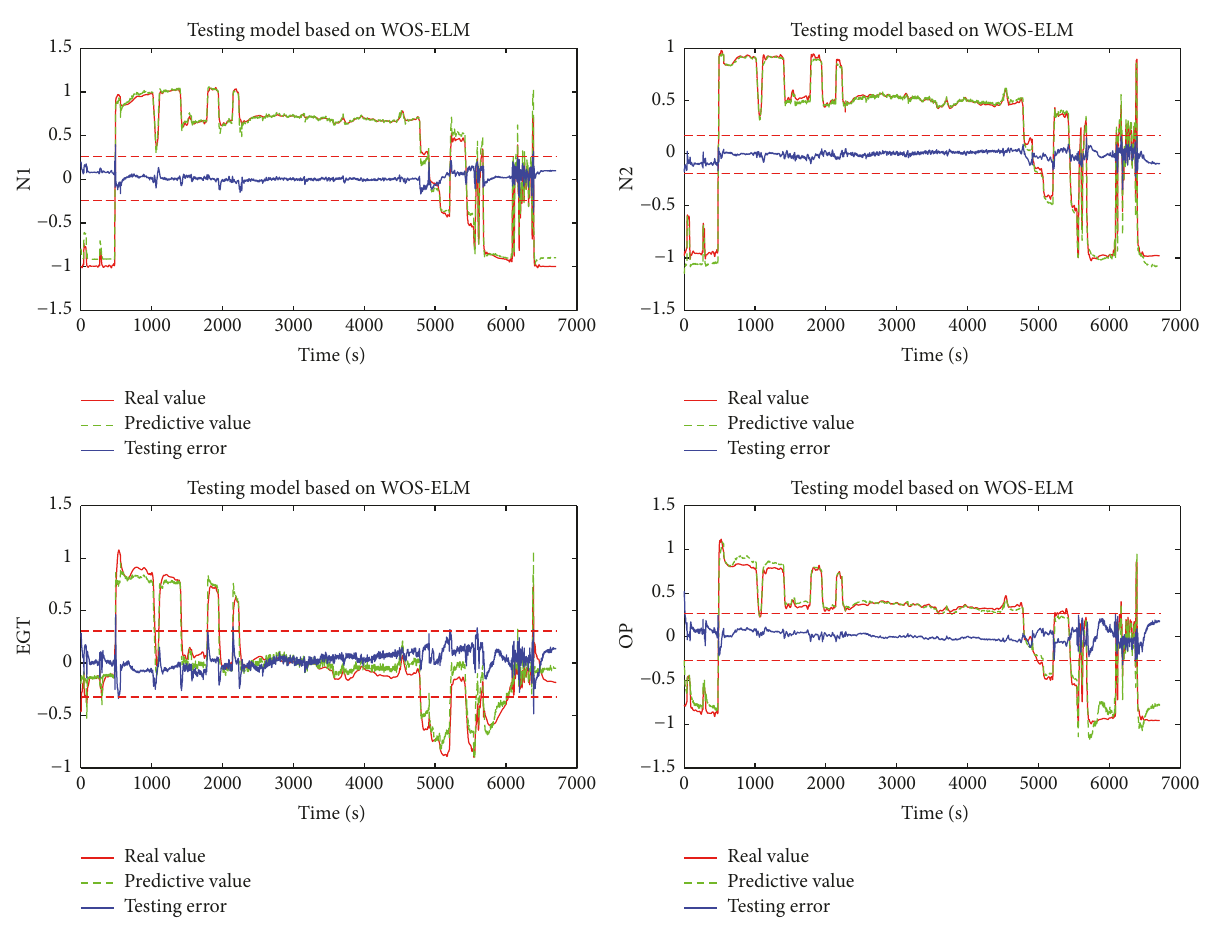
Figure 5: Testing results for sensors under normal